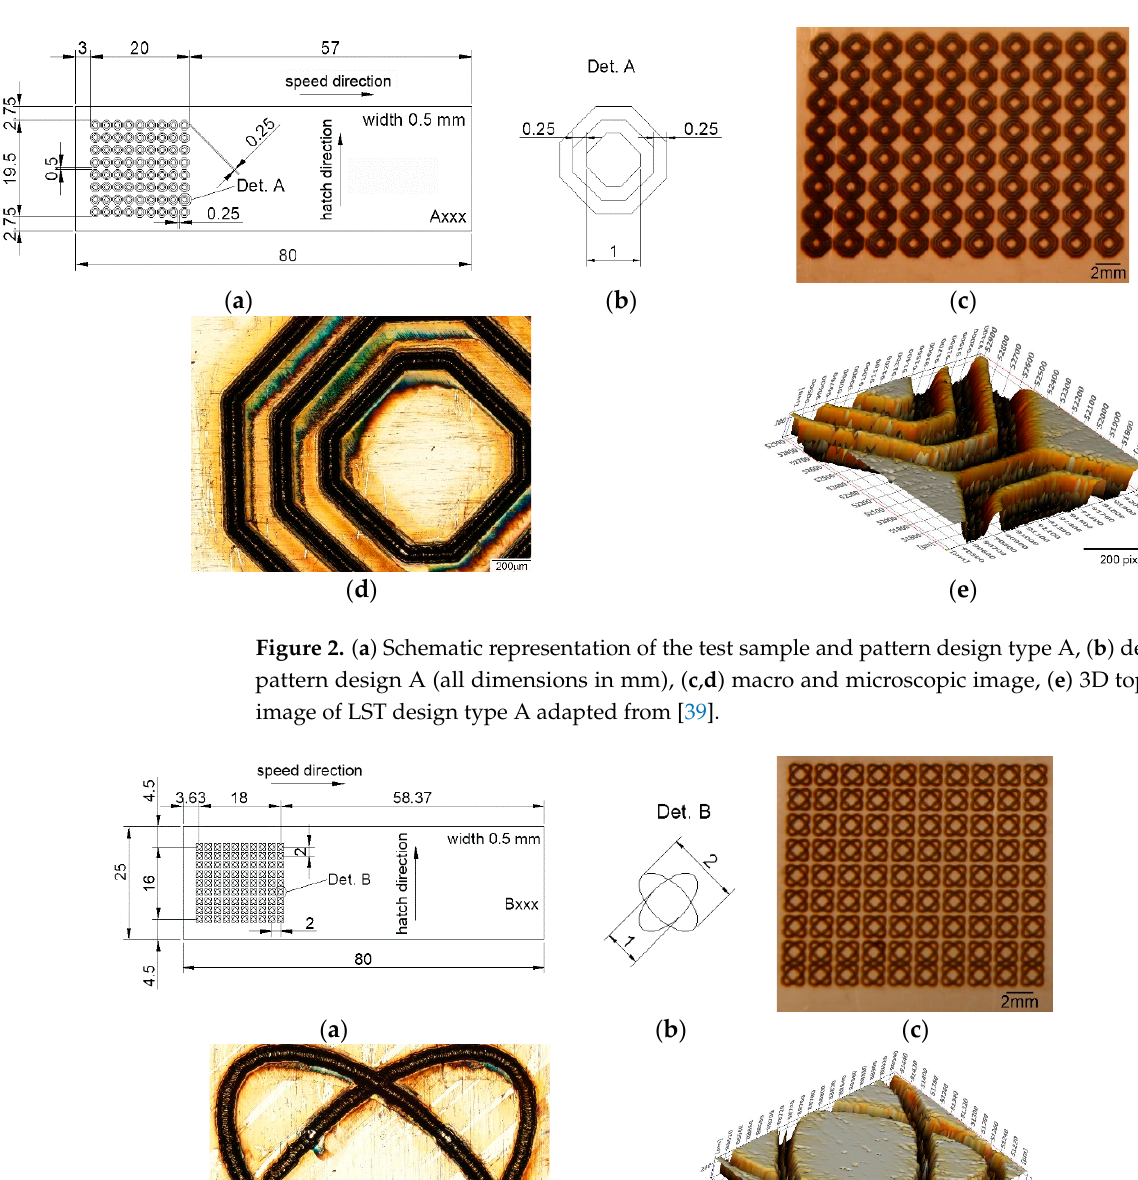
Figure 2. ( a ) Schematic representation of the test sample and pattern design type A, ( b ) detail of the pattern design A (all dimensions in mm), ( c , d ) macro and microscopic image, ( e ) 3D topographic image of LST design type A adapted from [39].